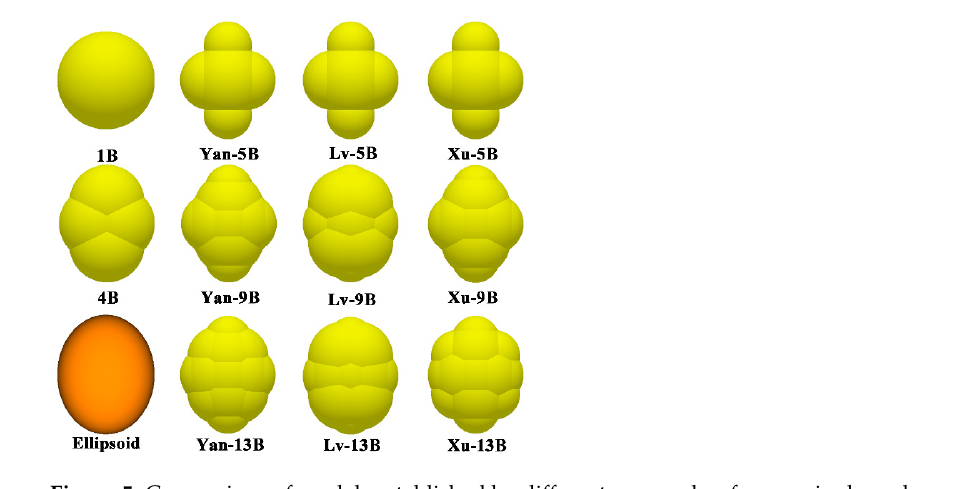
Figure 4. Comparison of models established by different approaches for one single soybean parti- cle of J-17.